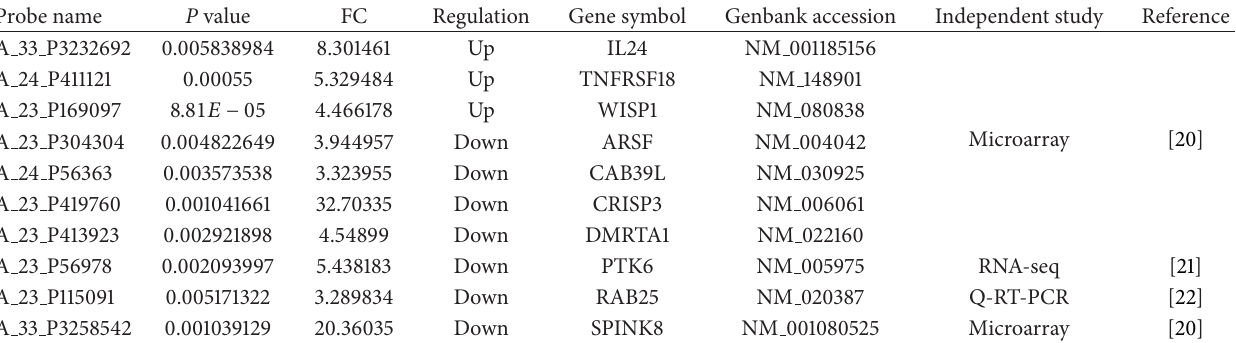
Table 1: Validation of selected differential expression of mRNAs in esophageal squamous cell carcinoma in independent